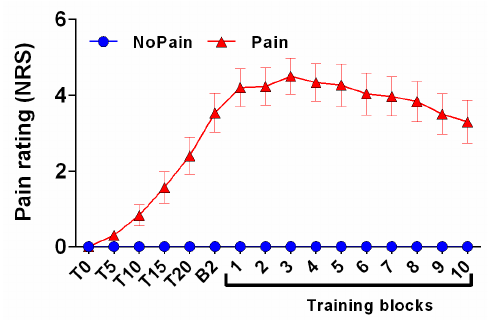
Figure 3. Time course of pain ratings. Subjects rated their pain on a numerical rating scale (NRS) immediately after capsaicin application and then every five minutes. The last measurement before training (B2) was taken right after the second baseline measurement, which corresponded to approximately 25 min after capsaicin application. NoPain group ratings are represented by blue circles and those of the Pain group as red triangles. Error bars represent the standard error of mean (SEM).